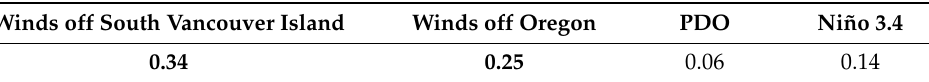
Table 2. Correlation coefficients between the first EOF mode of the longshore surface current anomalies and potential forcing factors.